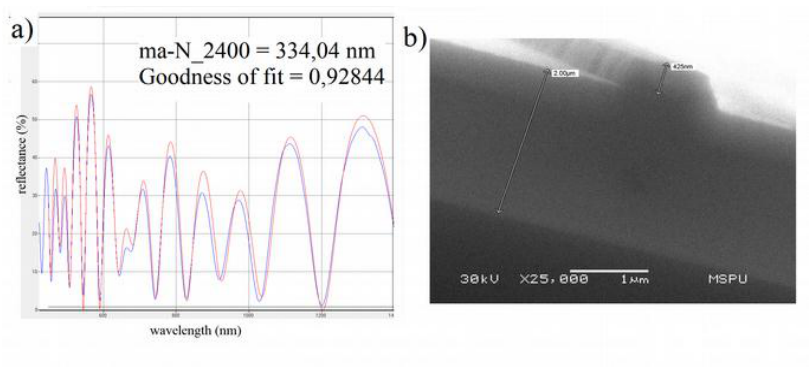
Fig. 2. Thickness of resist ma-N 2403 before etching, measured using Filmetrix F20 (a) and the waveguide cross-section with ma-N 2403 atop after etching